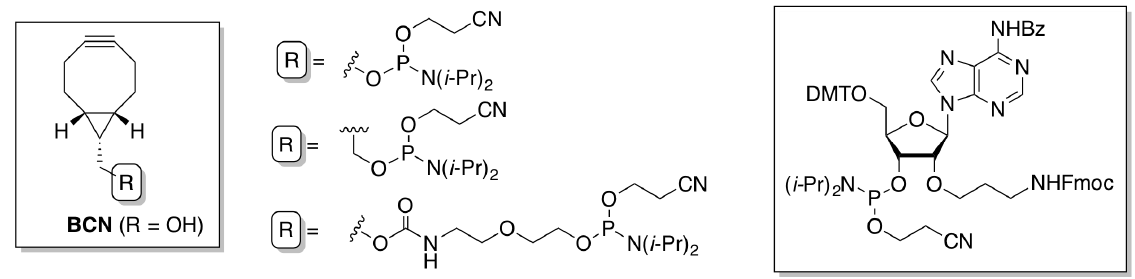
Figure 1. Structures of BCN- and adenosine-based phosphoramidites for incorporation into and copper-free conjugation of